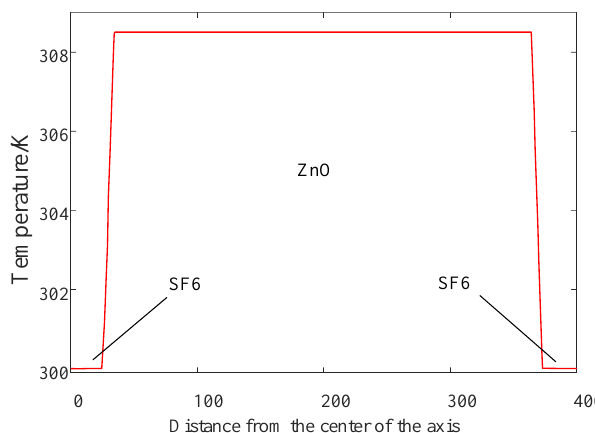
Figure 16. The radial temperature distribution of seventh group valve plate.